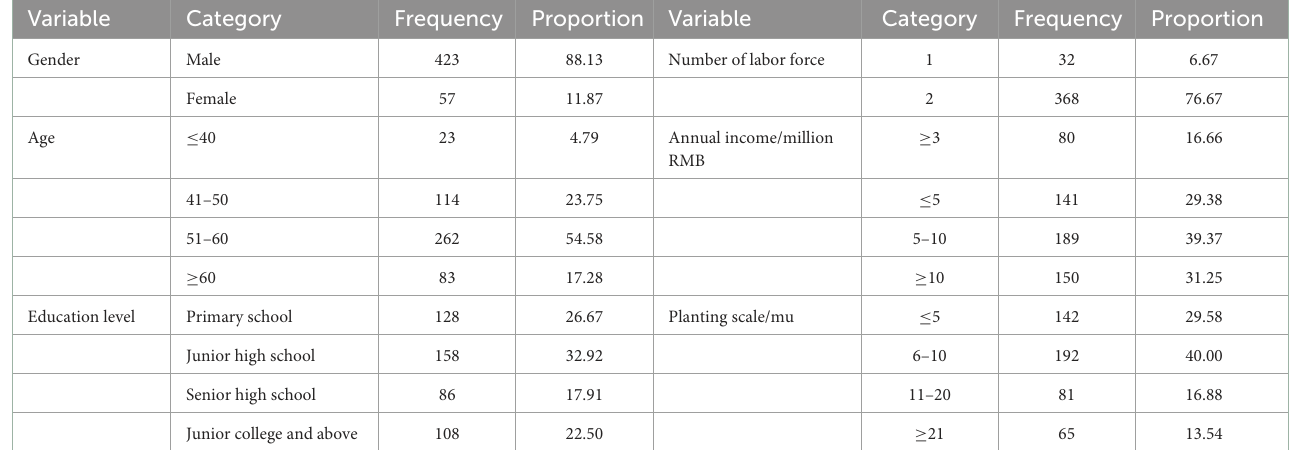
TABLE 1 Basic information of sample farmers.